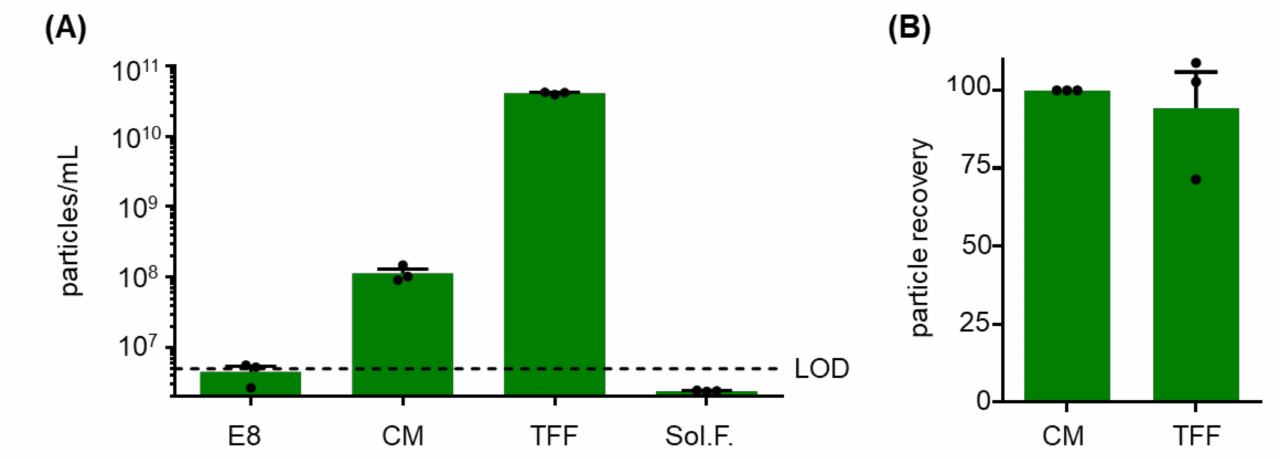
Figure A1. Preliminary results of 3D large scale culture for EV production. ( A ) Particle counts and ( B ) recovery in a pilot experiment using 3D human iPSC cultures in the DASbox Mini Bioreactor System (DASGIP-Eppendorf) as measured by tunable resistive pulse sensing (TRPS). Serum-free defined E8 medium showed particle counts at or below the limit of detection (LOD; dotted line) of the measurement system. This enabled accurate analysis of iPSC-derived particles, presumably representing extracellular vesicles, in iPSC-conditioned medium (CM) before and after enrichment by tangential flow filtration (TFF) with particle recovery comparable to the main study (technical triplicate analysis).